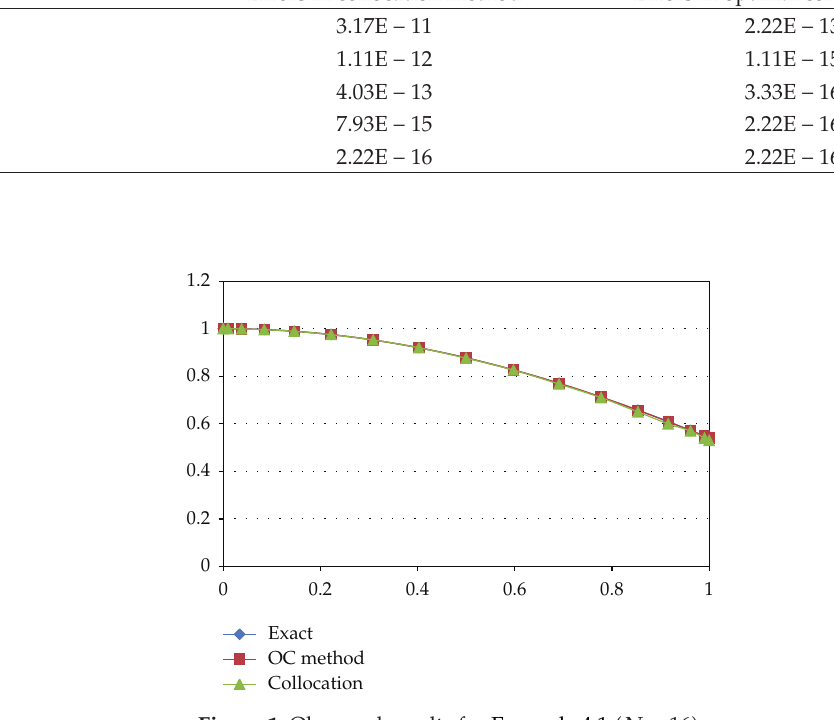
Figure 1: Observed results for Example 4.1 (cid:2) N (cid:7) 16 (cid:3)